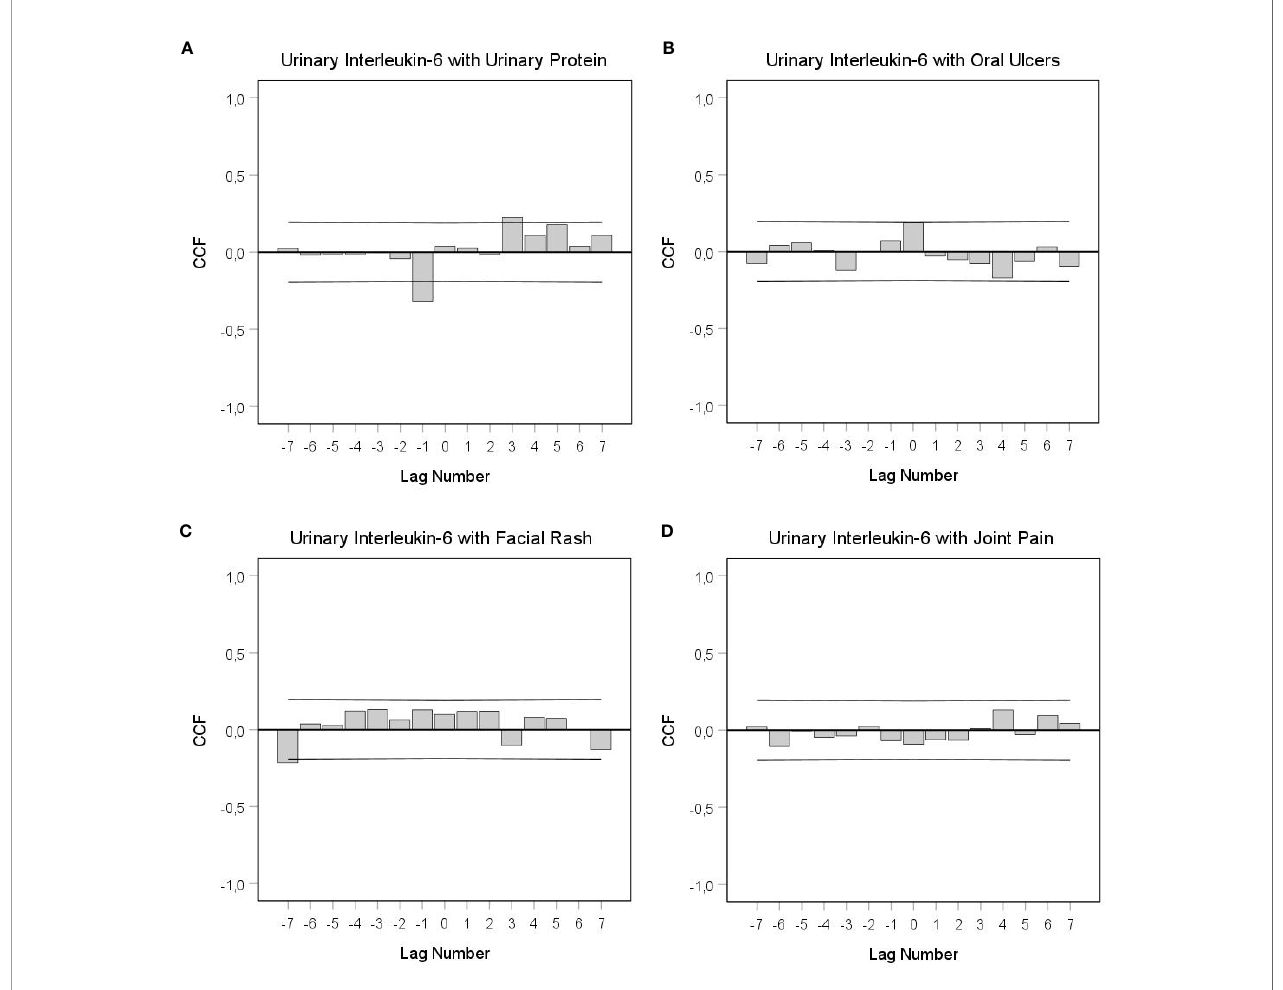
FIGURE 2 | Cross-correlational functions (CCF) between urinary IL-6 levels and SLE-speci fi c symptoms. (A) IL-6 with urinary protein, (B) IL-6 with oral ulcers, (C) IL-6 with facial rash, (D) IL-6 with small joint pain. Each lag represents a time interval of 12 h. Cross-correlation coef fi cients (bars) that reach the upper or lower limits of the 95% con fi dence intervals (lines) are signi fi cant at p < 0.05. A positive lag signi fi cance means that urinary IL-6 levels precede SLE-related symptoms; a negative lag signi fi cance means that SLE-related symptoms precede urinary IL-6 levels. Lag0 in this study can mean concurrency, positive lag (within 12 h) or negative lag (within 12 h). Clearly in (A) , but perhaps also in (B) , there is a change in the sign of the cross-correlation function between positive and negative lags, which indicates negative feedback